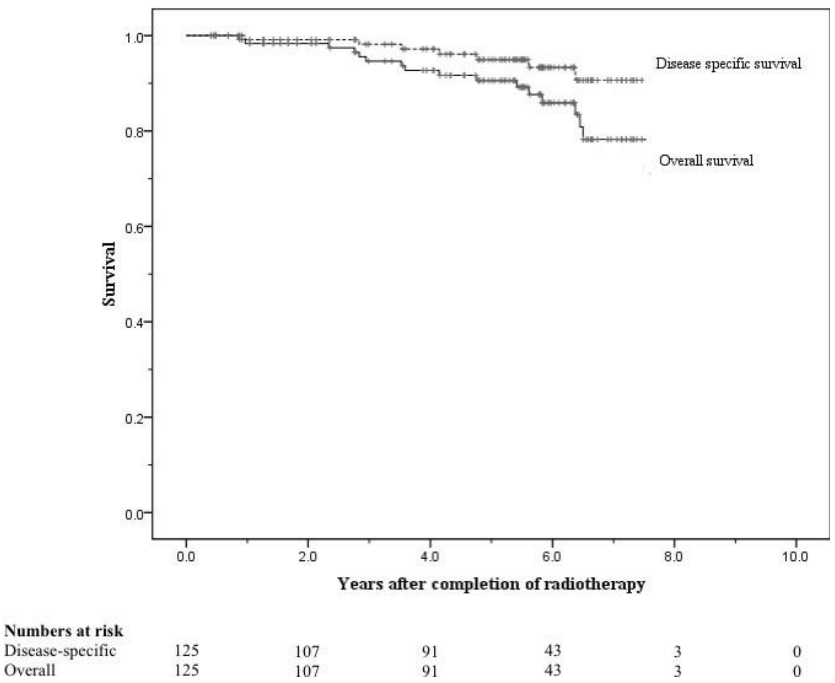
Figure 7. Disease-specific survival and overall survival for the entire